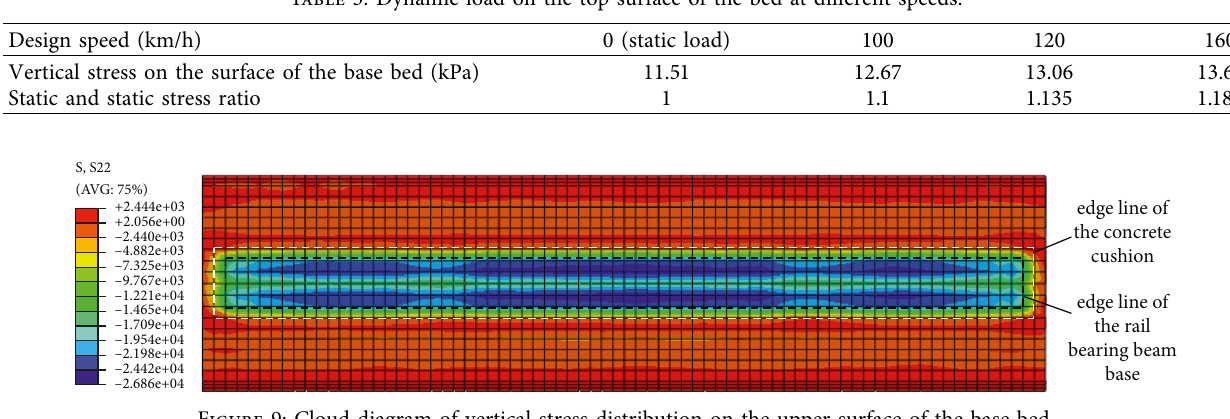
Table 3: Dynamic load on the top surface of the bed at different speeds.